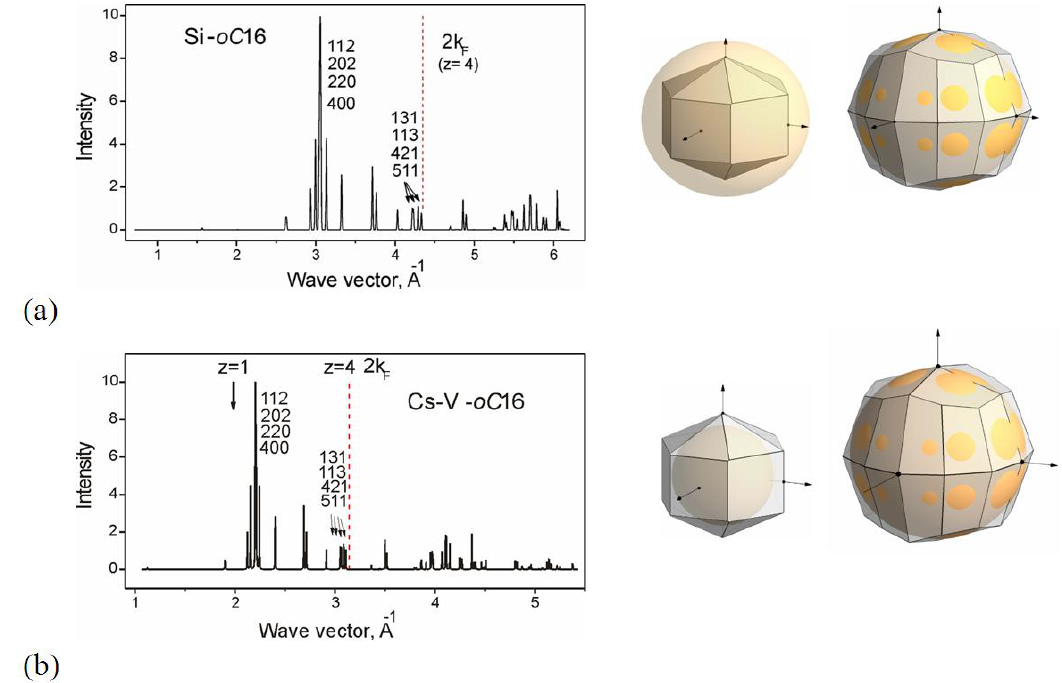
Figure 2. Simulated diffraction patterns (left) and constructed Brillouin-Jones zones (right) ( a ) for Si- oC 16; and ( b ) for Cs- oC 16 with the data from Table 2. Indices hkl for reflections selected for BZ constructions are indicated on the patterns. The position of 2k dotted (red) line. See discussion in the